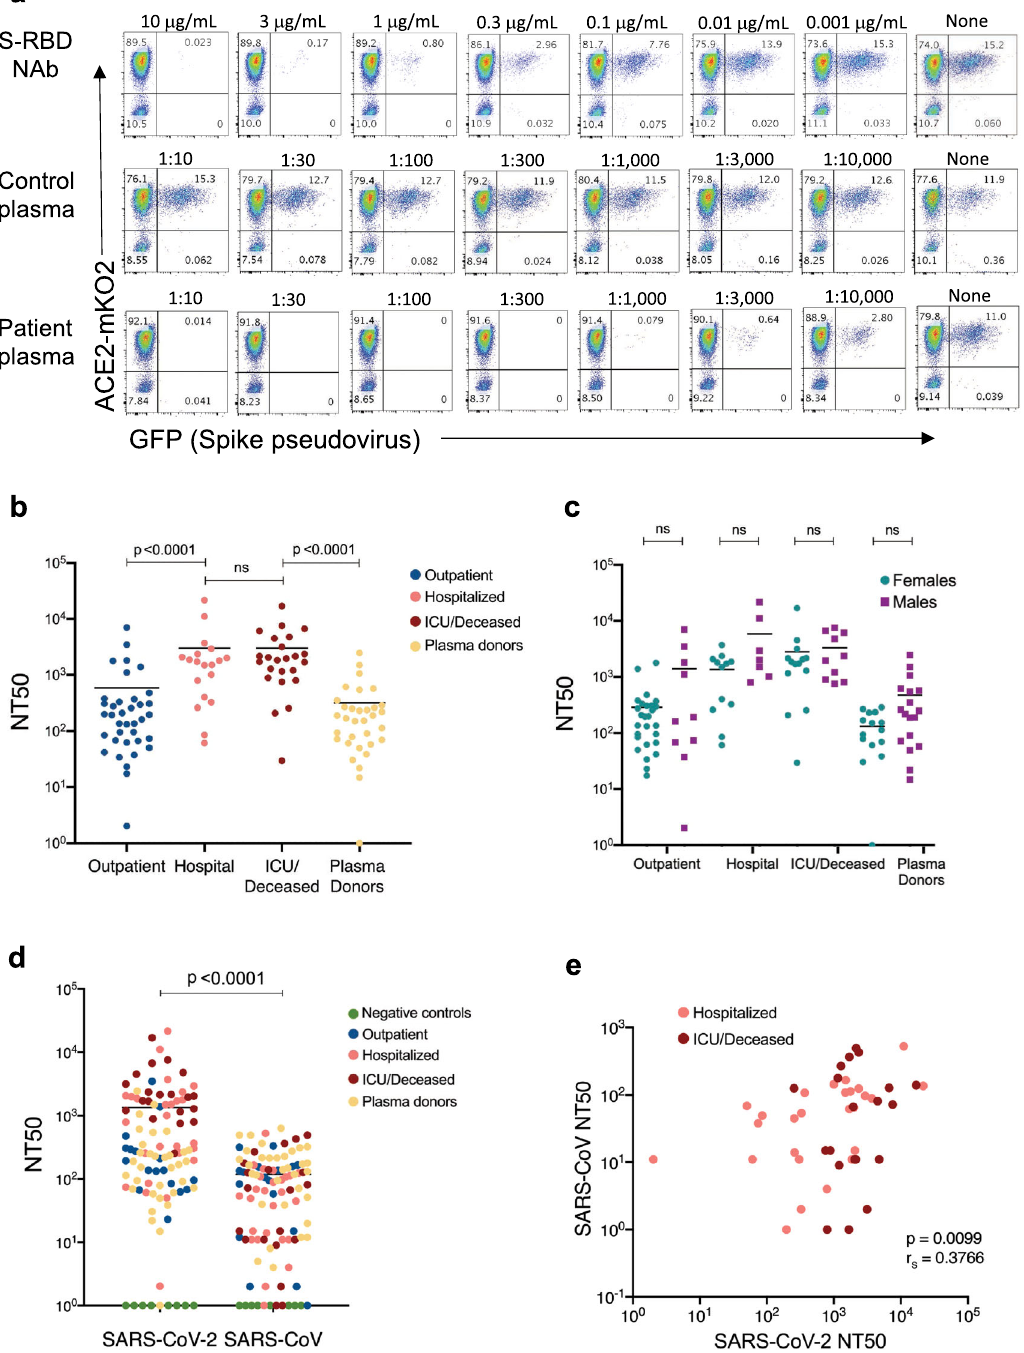
Fig. 5 Neutralizing titers for SARS-CoV-2 and SARS-CoV in COVID-19 subject plasma. a Neutralization assay with S-RBD-speci fi c NAb, healthy control plasma, and a COVID-19 patient plasma. Threefold serial dilutions of NAb from 10 μ g/ml to 1 ng/ml or the plasma from 1:10 to 1:10,000 were pre- incubated with spike protein pseudovirus and added to 293-ACE2 cells. GFP expression was analyzed by fl ow cytometry 3 days post infection. b SARS- CoV-2 neutralization titers (NT50) of COVID-19 plasma grouped as an outpatient, hospitalized, ICU or deceased and convalescent plasma donor groups ( n = 113). c NT50 of COVID-19 patient and plasma donor groups subdivided into males and females ( n = 113). d Comparison of NT50 of COVID-19 plasma for SARS-CoV-2 and SARS-CoV neutralization. SARS-CoV-2 or SARS-CoV pseudoviruses were pre-incubated with COVID-19 plasma from all severity groups ( n = 104), 293-ACE2 cells were infected and RFP expression was determined at day 3 using fl ow cytometry. e Graph of SARS-CoV-2 NT50 values from hospitalized subjects plotted against SARS-CoV ( n = 46). Two-tailed Mann – Whitney U test was used to determine the statistical signi fi cances in fi gures ( b ), ( c ) and ( d ) and two-tailed Spearman ’ s was used for fi gure ( e ). Horizontal bars in ( b ), ( c ) and ( d ) indicate mean